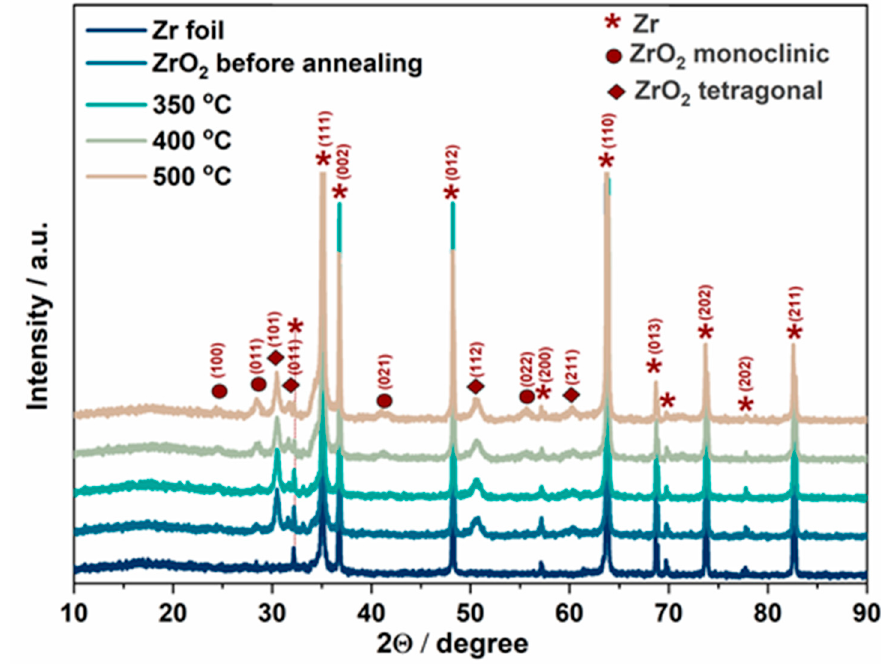
Figure 3. X-ray diffraction (XRD) patterns of Zr substrate and anodic nanoporous ZrO 2 layers before and after annealing at 350 °C, 400 °C and 500 °C .